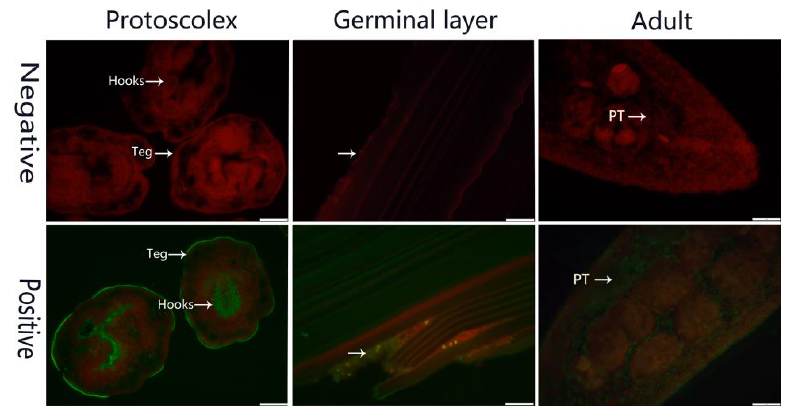
Figure 4. Immunofluorescence localization of Eg-LAP in all stages of E. granulosus . Eg-LAP in the protoscolex, germinal layer and adult worm labeled by incubation with specific anti-rEg-LAP IgG (positive), or preimmune serum (negative), then with FITC-conjugated anti-rabbit IgG. Teg, tegument; PT, parenchymatous tissue. Scale bars: 50 µ